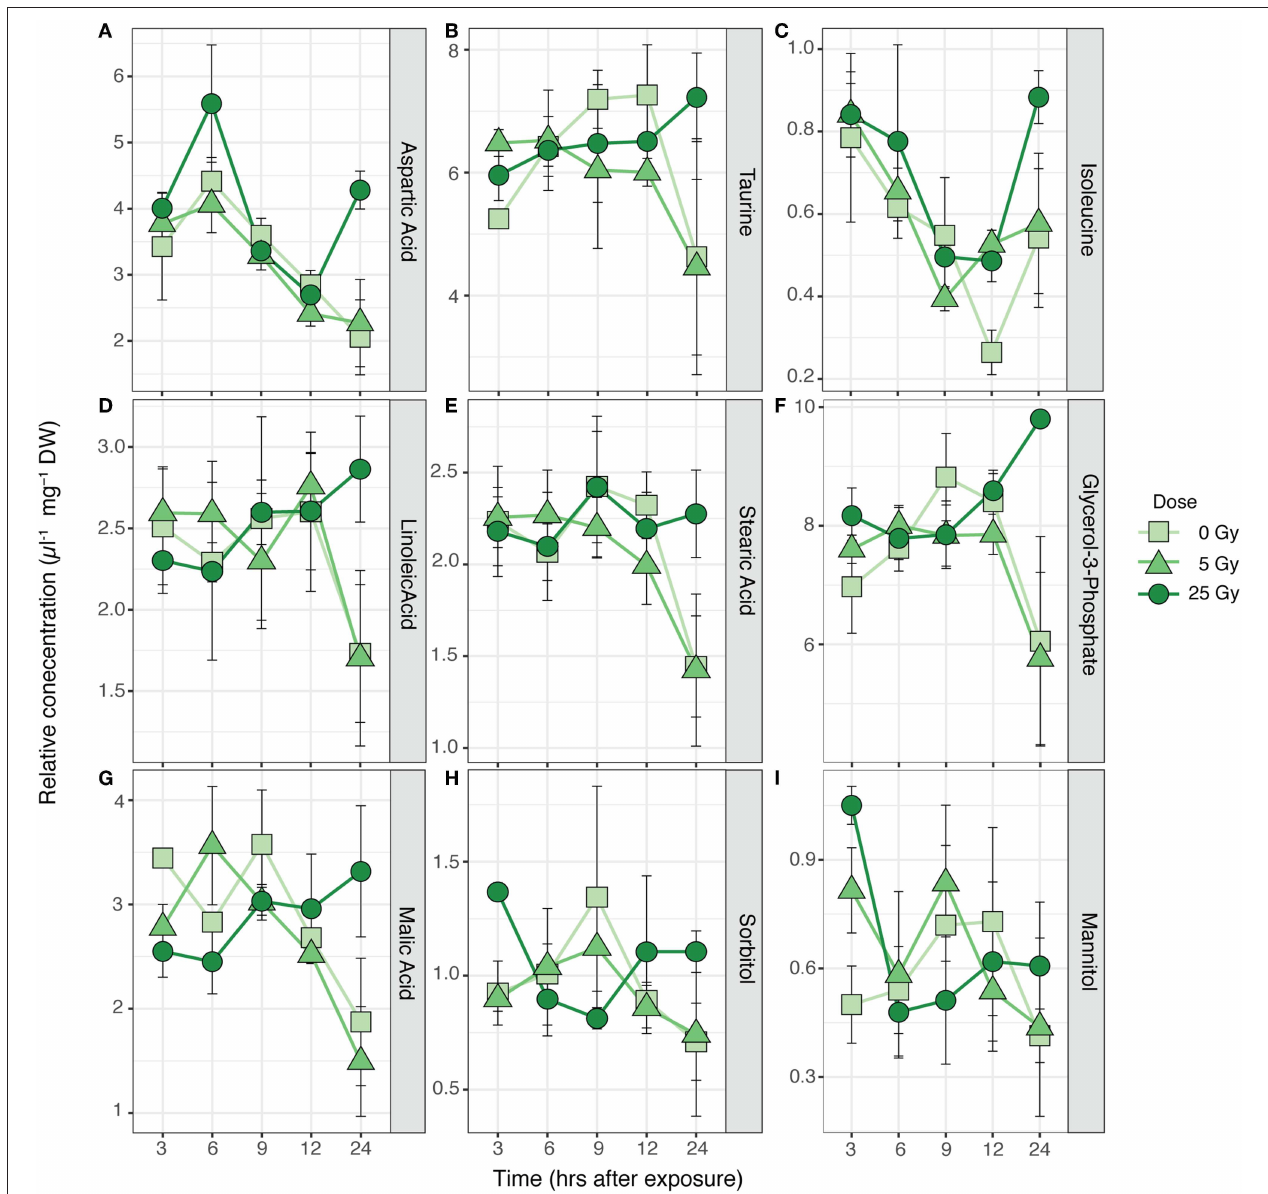
FIGURE 2 | Time series of average relative concentrations ( ± SE) of the metabolites identified by the SIMPER analysis as contributing 80% to the cumulative dissimilarity between times after exposure ( Table S1 ) in R. subcapitata ( n = 3). (A) Aspartic acid, (B) taurine, (C) isoleucine, (D) linoleic acid, (E) stearic acid, (F) glycerol-3-phosphate, (G) malic acid, (H) sorbitol, and (I) mannitol.